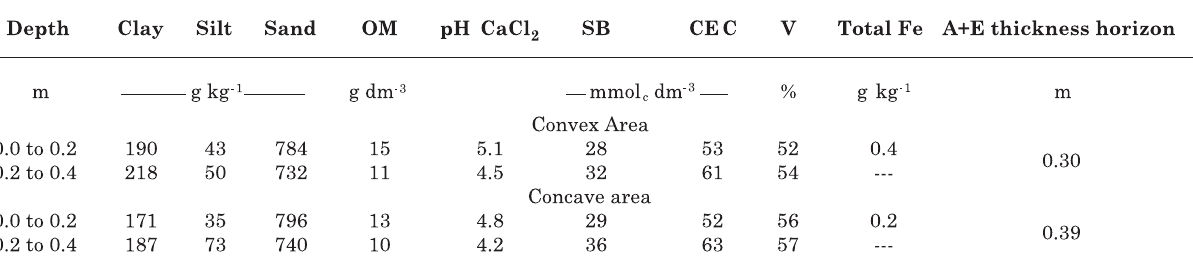
Table 1. Granulometric, chemical and A+E thickness horizon attributes of the convex and concave hillslope curvatures (an average 121 points in each